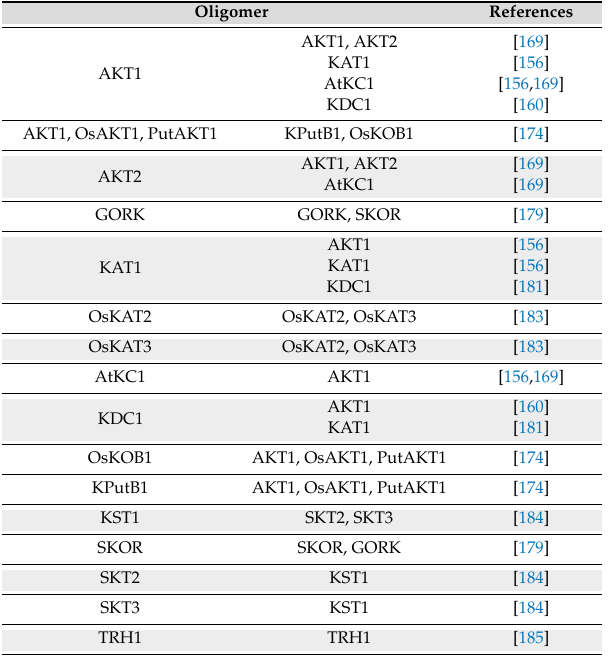
Table 4. Oligomers of K + / Na + transporters / channels detected using protein–protein interaction techniques in yeast.